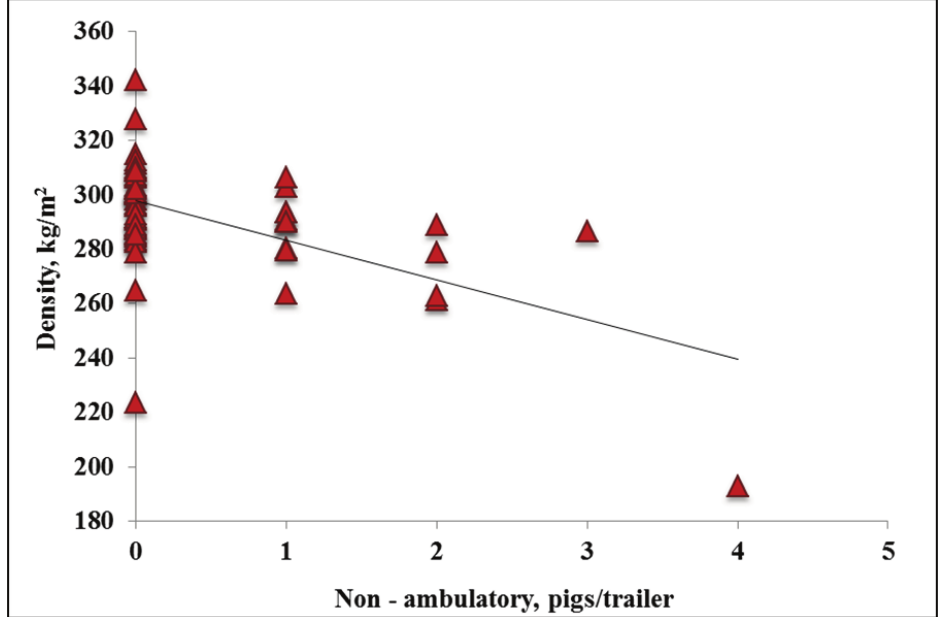
Figure 4. Experiment 2. Effects of density on trailers on non-ambulatory pigs per trailer in market weight pigs at unloading in HOT weather ((cid:2)26.7 °C; p = 0.01, R 2 = 0.32).